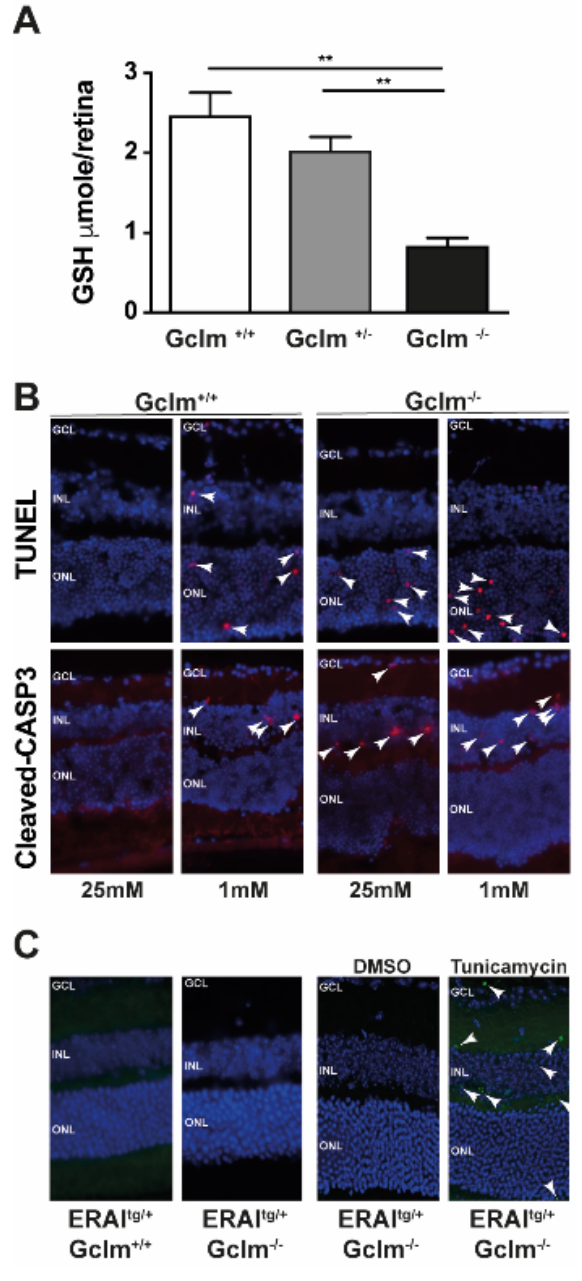
Figure 5. Cell death is activated in Gclm KO mice, but it is not related to UPR in ERAI tg/+ /Gclm KO mice. ( A ) GSH quantification in retinas of adult Gclm +/+ (WT), Gclm +/ − and Gclm − / − mice. Results are expressed as mean ± SEM of 4 retinas for Gclm +/+ (WT) and 3 retina for Gclm +/ − and Gclm − / − . ** p < 0.005. ( B ) TUNEL and activated-caspase3 staining of Gclm +/+ and Gclm − / − mice retinas after 24 h of culture under conditions of high (25 mM) and low (1 mM) glucose concentration. White arrows show TUNEL-positive cells. Results are representative of 2 retina per condition. ( C ) GFP staining of adult ERAI tg/+ /Gclm +/+ and ERAI tg/+ /Gclm − / − mice retinas. Intravitreal injection of Tunicamycin 10 ng/kg was used as a positive control and DMSO 0.2% in the contralateral eye was used as a negative control. White arrows show GFP-positive cells. Results are representative of 2 retina per condition. GCL: ganglion cell layer, INL: inner nuclear layer, ONL: outer nuclear